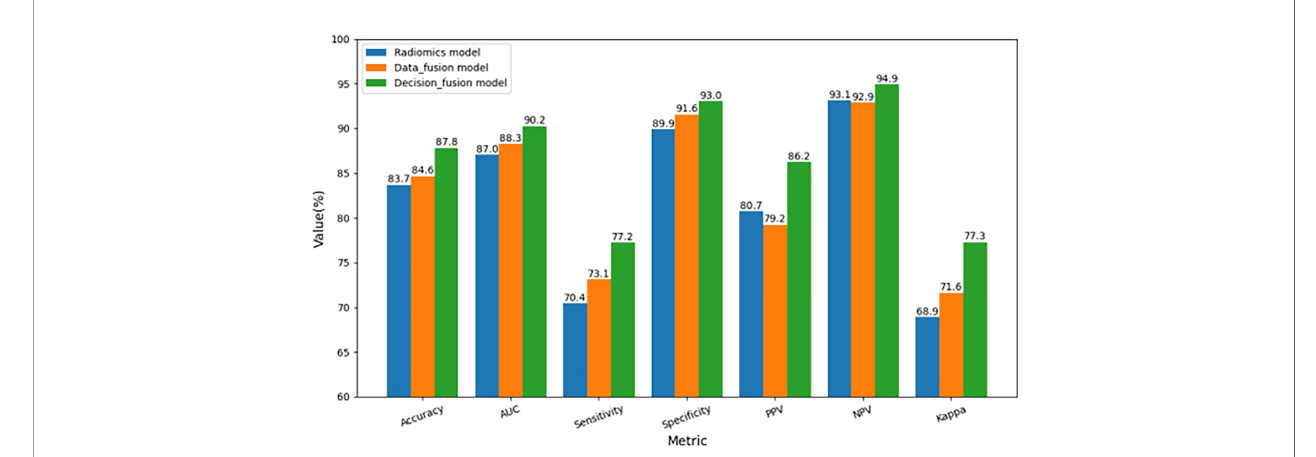
FIGURE 5 | Comparison of three-fold cross-validation performance of the three multimodal prediction